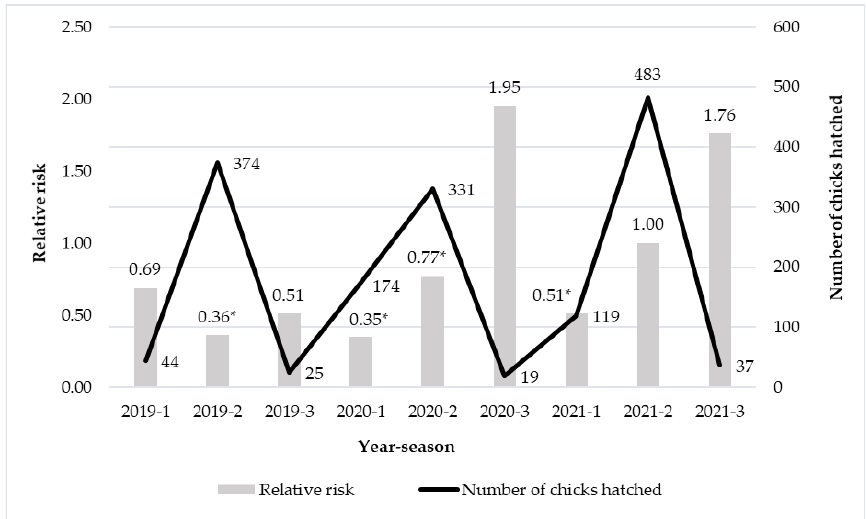
Figure 1. The effect of the year of the breeding period on the relative risk of total loss. The seasons are numbered: -1: spring, -2: summer, -3: autumn. * Statistically significant difference from the reference group ( p ≤ 0.05).